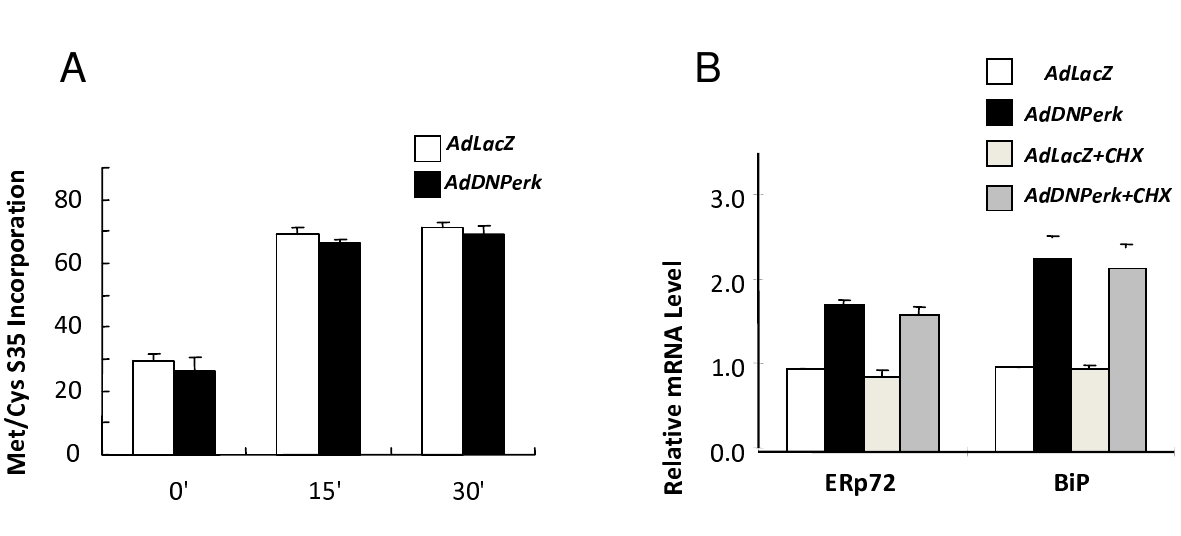
Figure 5 Global protein synthesis is normal following acute ablation of PERK . A. Incorporation of 35S translabel into total TCA-precipitable protein did not differ between AdDNPerk -infected and AdLacZ -infected cells at 24 hr (A) or 16 hr post-trans- duction (data not shown). Values are means ± SE from three replicate samples. B. Cyclohexamide (CHX) did not inhibit the induction of ERp72 and BiP mRNA in AdDNPerk -infected 832/13 cells. At 12 hr post-transduction, cells were treated with 5 mg/ml CHX for 4 hours before RNA was extracted for Real-time quantitative RT-PCR. Values are means ± SE, from three rep- licate samples.